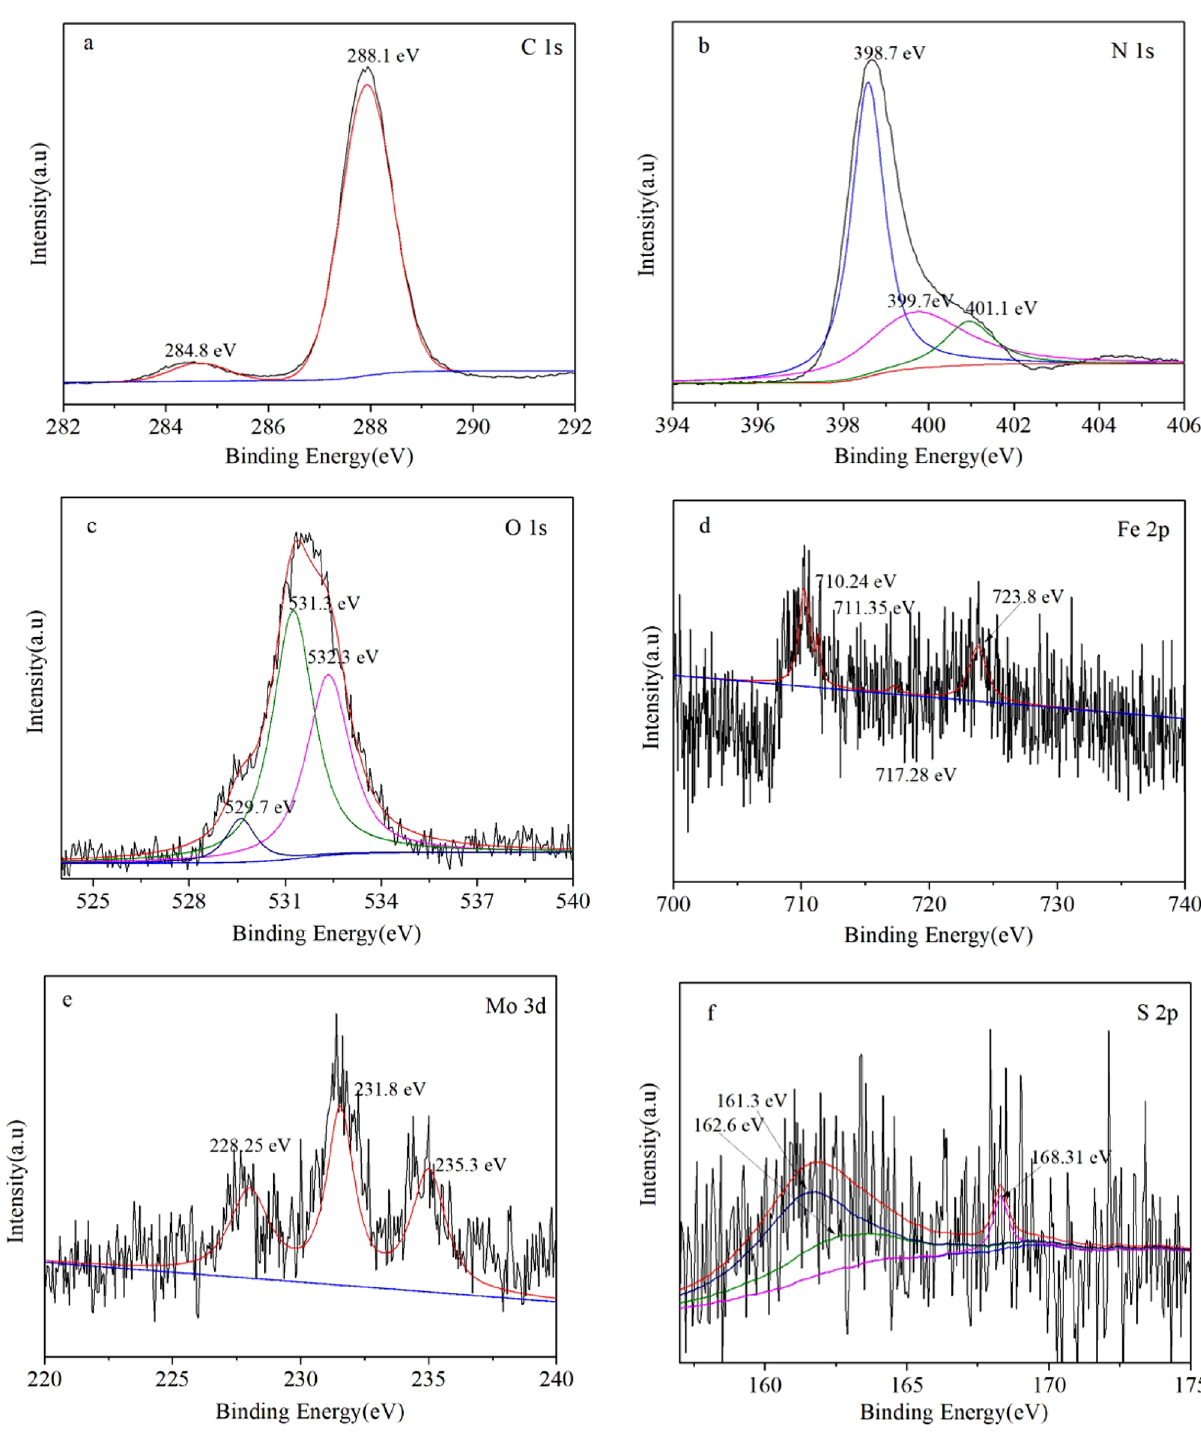
Figure 5. XPS spectra of 1%MoS 2 /Fe 2 O 3 /CN, ( a ) C 1s spectrum, ( b ) N 1s spectrum, ( c ) O 1s spectrum, ( d ) Fe 2p spectrum, ( e ) Mo 3d spectrum, ( f ) S 2p